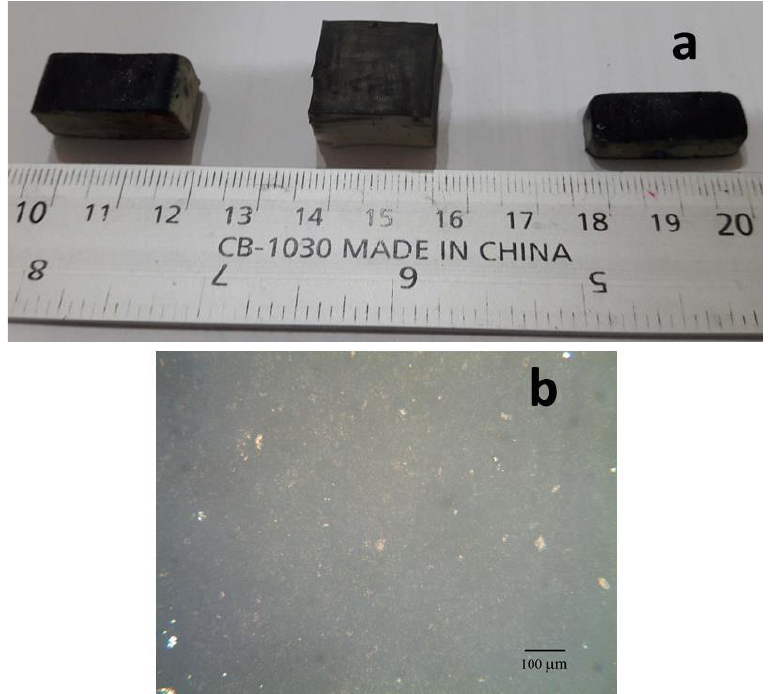
Figure 9. Pictures of the samples showing the 3D images of the rubber substrates covered with the CNT – oil and NiPc – oil jellies ( a ) and the magnified image of the top surface of the rubber substrate covered with the CNT – oil and NiPc – oil jellies ( b ).